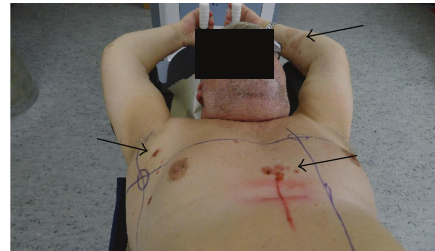
Figure 3: Skin lesions at the time of simulation before palliative radiotherapy to the mediastinum and left axilla. Bullous pemphigoid mainly involving trunk and arms.